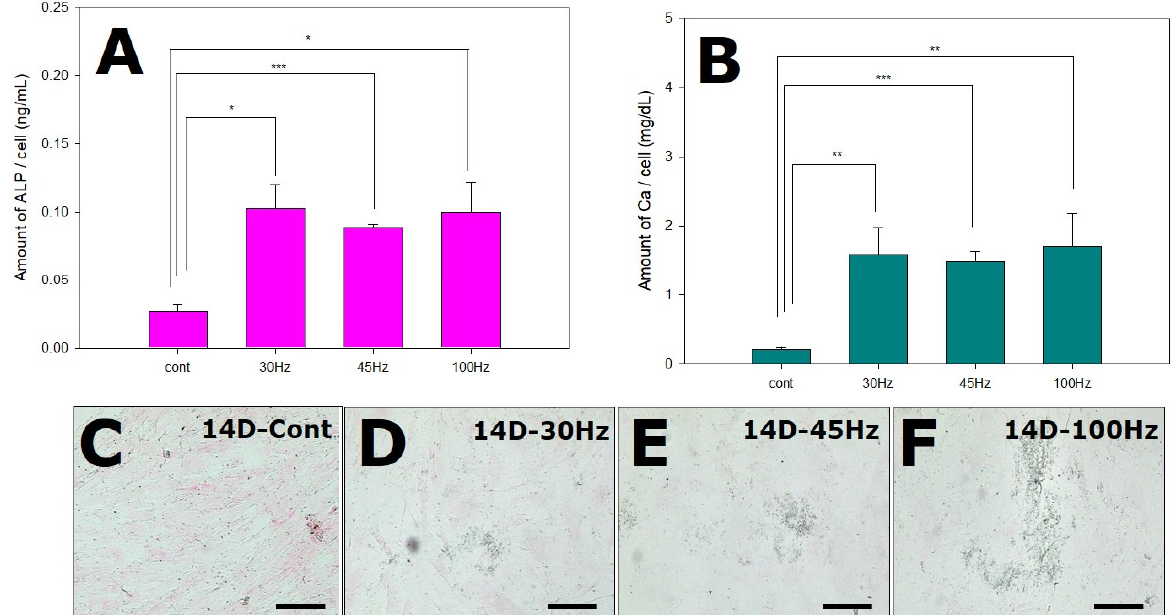
Figure 5. Influence of mechanical vibration on alkaline phosphatase (ALP) production ( A ) and calcium ( B ) and mineral ( C – F ) deposition by human dental pulp stem cells. All of mechanical vibration groups showed similarly elevated levels of alkaline phosphatase, and the degree of calcium deposition was increased in the vibrated groups ( n = 3). Von Kossa staining showing mineral deposition in the cells ( C – F , black spots). * p < 0.05, ** p < 0.01, *** p < 0.005, ( C – F ) von Kossa staining, Original magnification: 200×, Scale bar: 100 μ m.